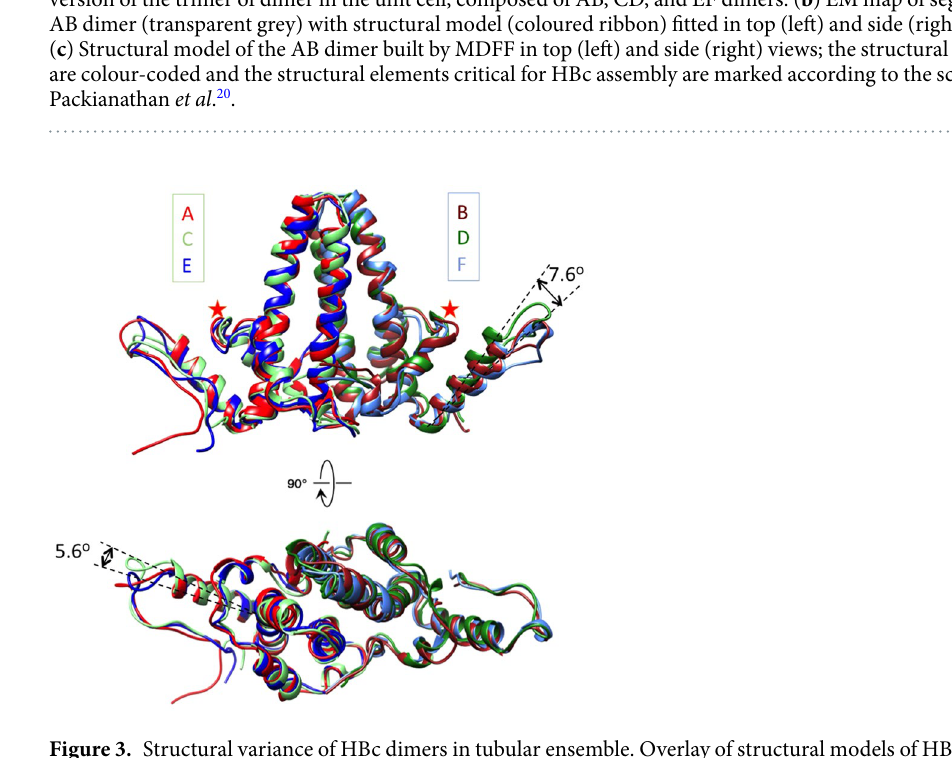
Figure 3. Structural variance of HBc dimers in tubular ensemble. Overlay of structural models of HBc dimers AB (red/brown), CD (light green/green), and EF (blue/cyan) from HBc tubular ensemble in side (upper panel) and top (lower panel) views. Significant conformational differences in helix α 5 and helix α 1 are indicated by arrows and stars